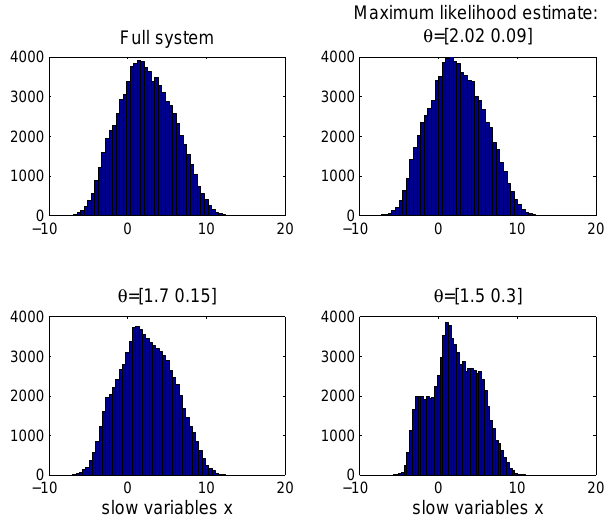
Fig. 13. Distribution of the state variables in the full Lorenz system (top left) and in the parameterized system with maximum likelihood estimate (top left) and two arbitrarily chosen “poor” parameter val- ues (bottom